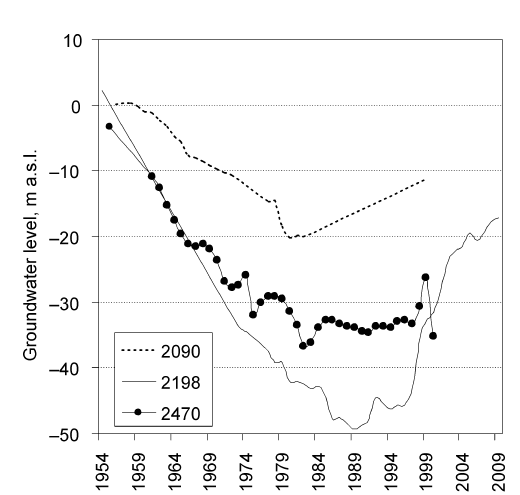
Fig. 4. Changes in groundwater levels in the Voronka ground- water body according to state groundwater monitoring